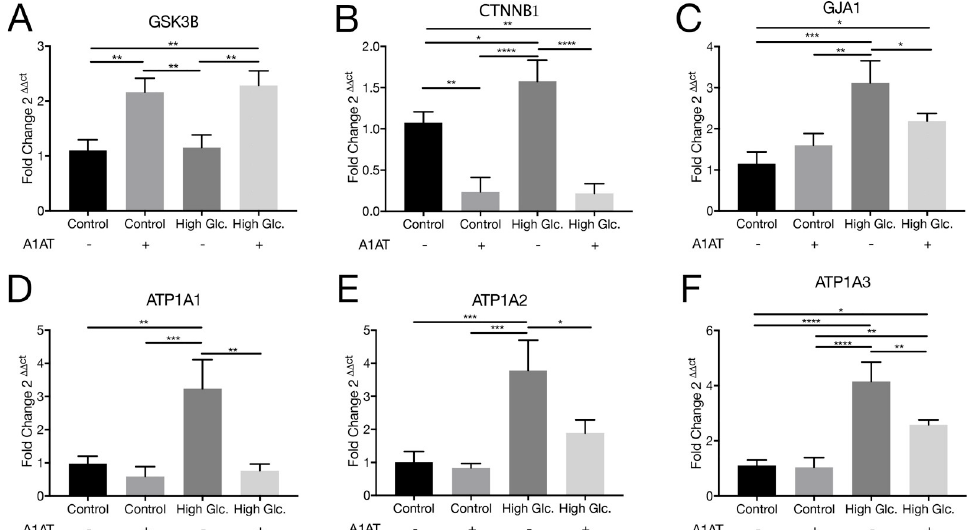
Fig 8. Wnt canonical pathway inhibited by A1AT. RT-qPCR was performed for Wnt canonical pathway mediators mRNA and targets regulated by this signaling pathway (A) GSK3B; (B) CTNNB1 gene related to β -Catenin expression; (C) Cx43 encoding gene GJA1; (D) ATP1A1, (E) ATP1A2, (F) ATP1A3 genes related to NKA alpha subunit isoforms α 1, α 2 and α 3. Data expressed as fold change with respect to control. High glucose group expressed as ‘High Glc’. Results were expressed as mean ± SD. � p < 0.05, �� p < 0.01, ��� p < 0.001, ���� p < 0.0001 vs.